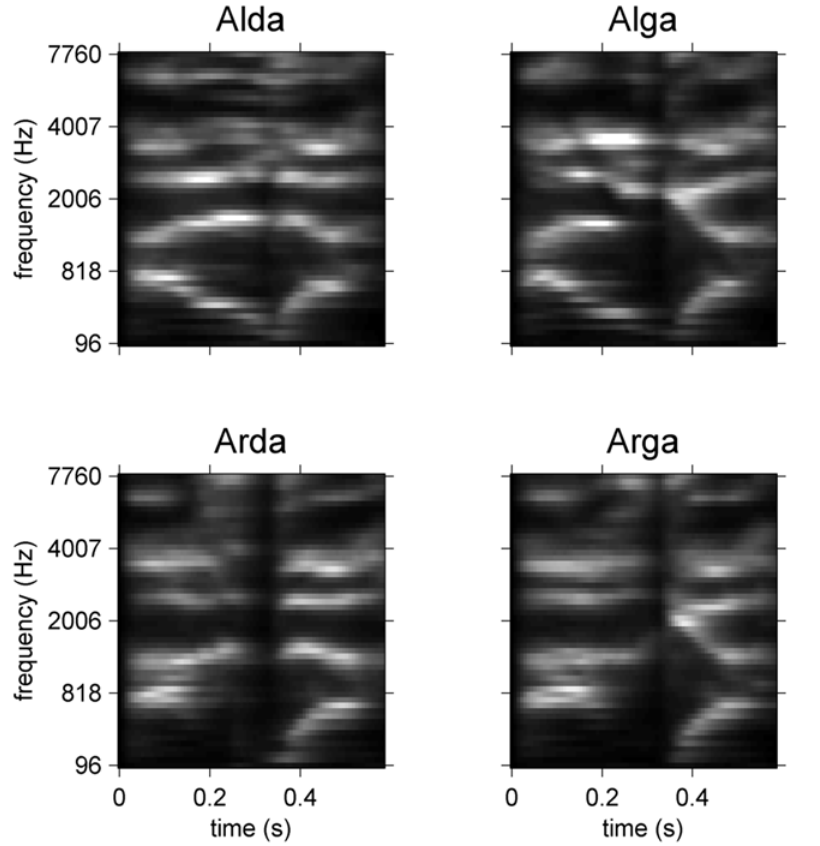
Fig 1. Cochleograms of the four stimuli involved in the experiment. Parameters for spectral and temporal resolution are identical to those used to derive the ACIs (see details in the main text).